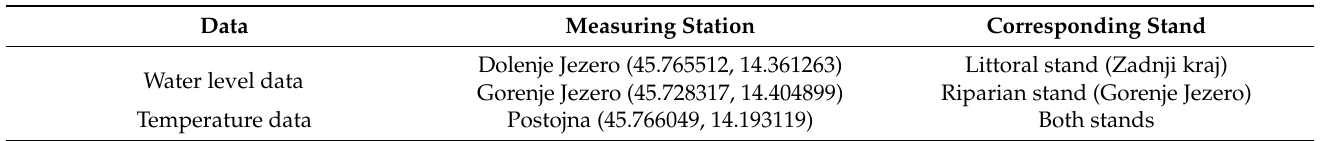
Figure 2. Map of lake Cerknica showing the observed areas of reed stands, the locations of water level measuring stations, floodplains, and the river Stržen. Table 1. Types of data acquired from measuring stations, locations of measuring stations with latitudes and longitudes, and their corresponding reed